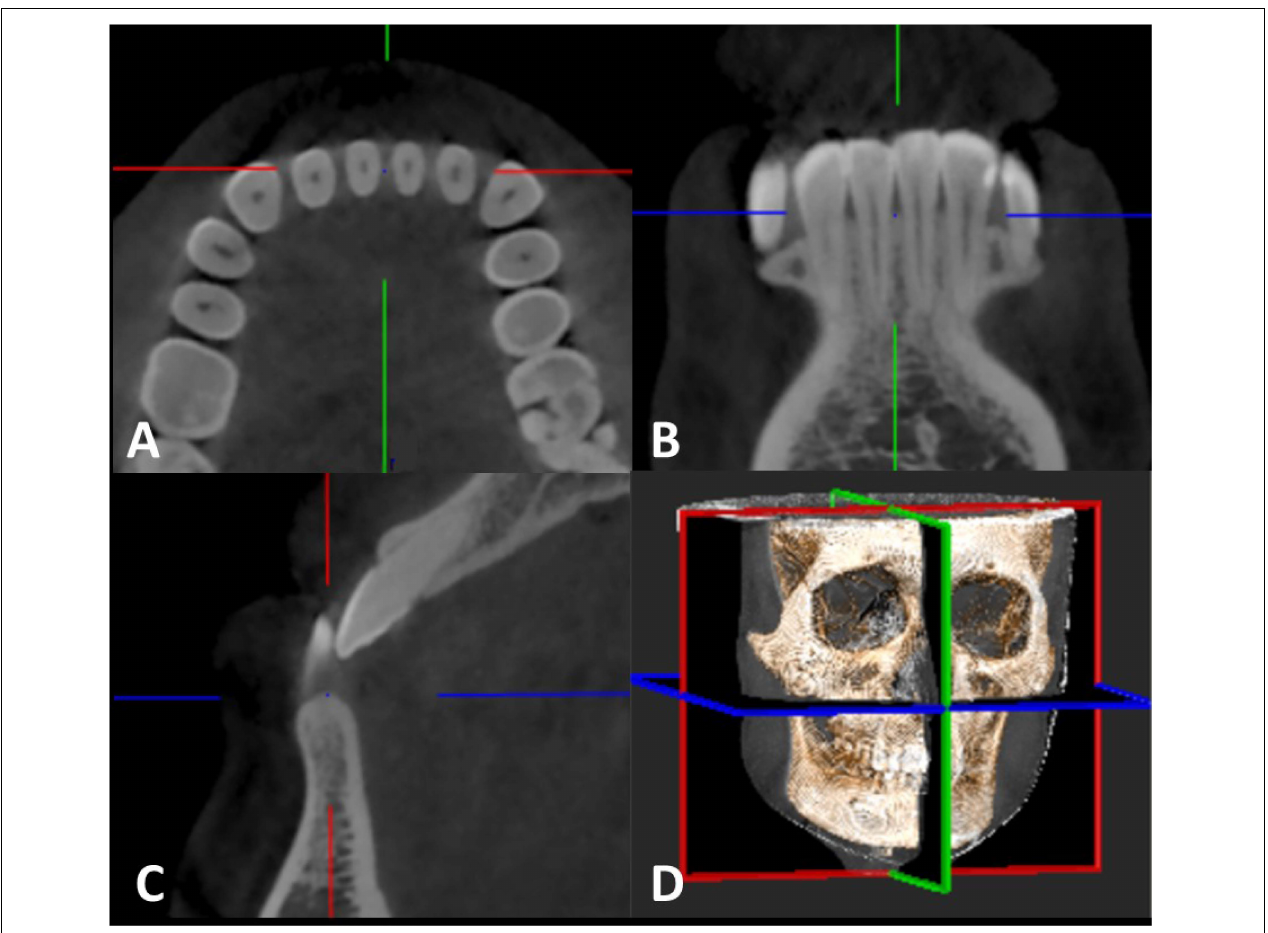
FIGURE 1 | CBCT scanning and 3D reconstruction: (A) horizontal view; (B) coronal view; (C) sagittal view; and (D) three-dimensional